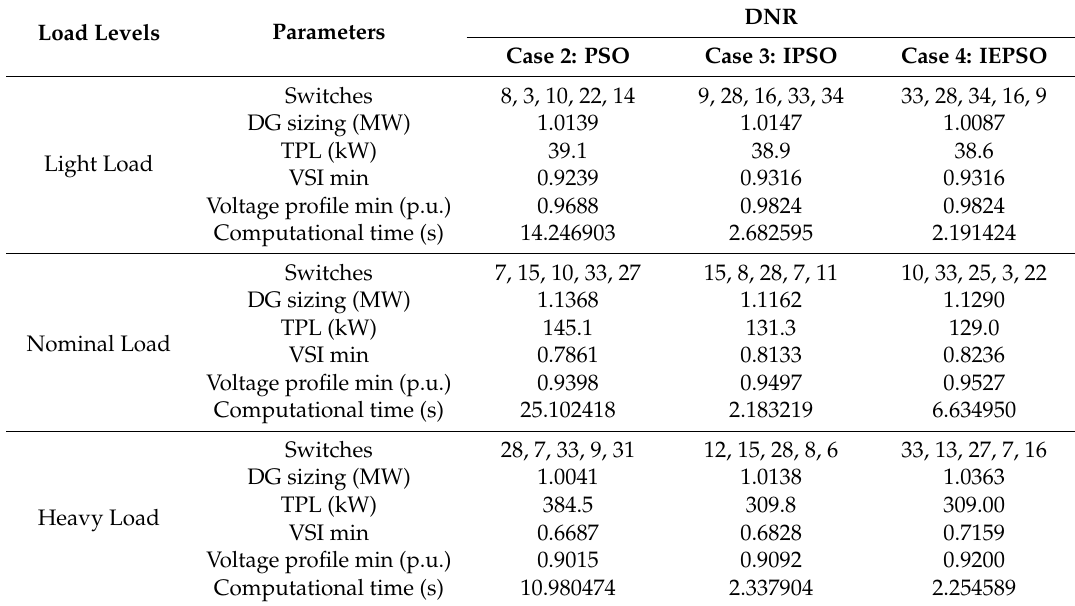
Table 4. The performance of PSO, IPSO and IEPSO for DNR with DG sizing implementation in 33-bus radial distribution